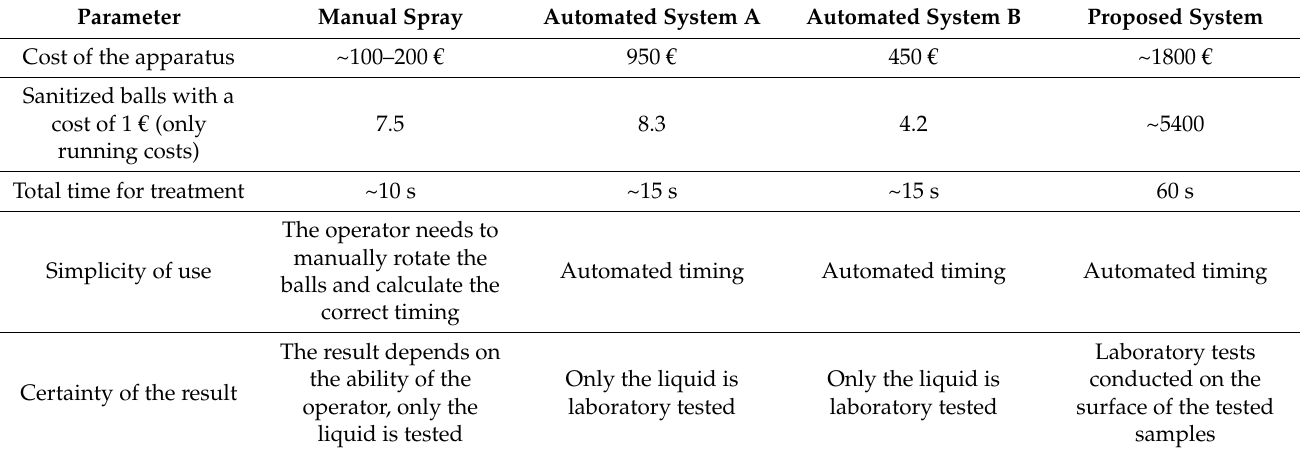
Table 3. Comparison of the proposed system with other available